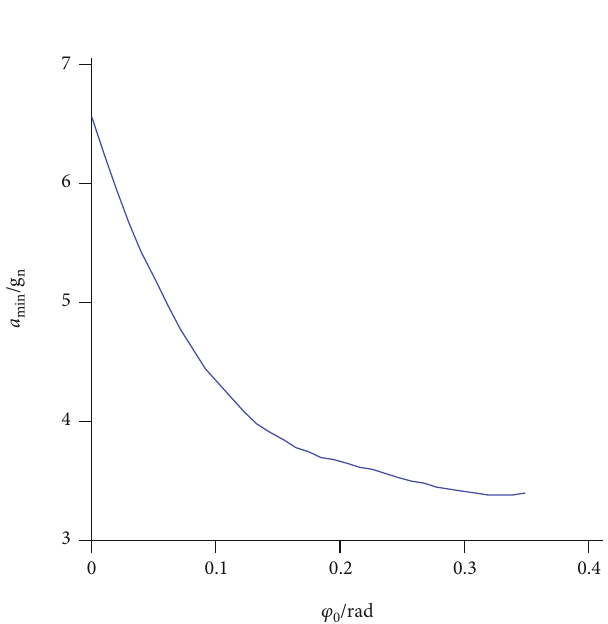
Figure 12: Body overload vs. time.